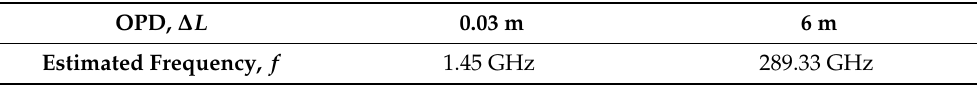
Table 1. Estimated target frequencies at OPD ∆ L = 0.03 m and ∆ L = 6 m.